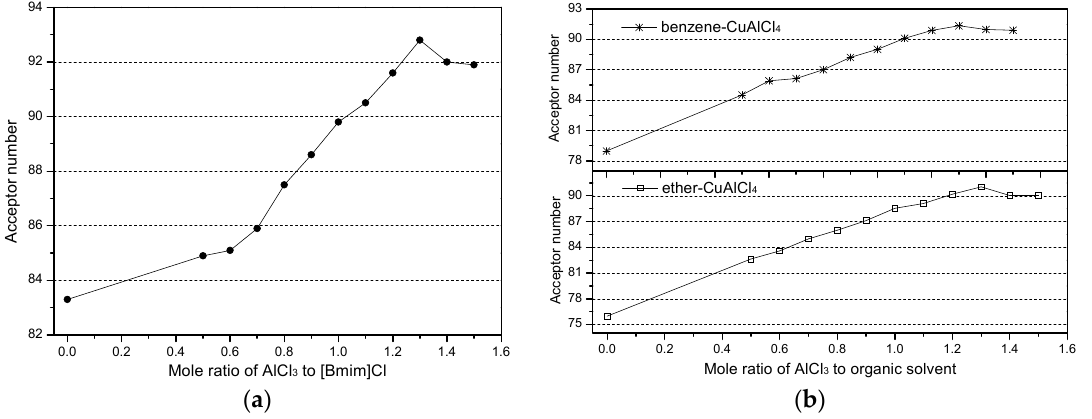
Figure 5. Effects of AlCl 3 on the acceptor number of chlorometallate ILs: ( a ) The relationship of AN and the mole ratio of AlCl 3 to [Bmim]Cl; ( b ) The relationship of AN and the mole ratio of AlCl 3 to [Bmim]Cl.